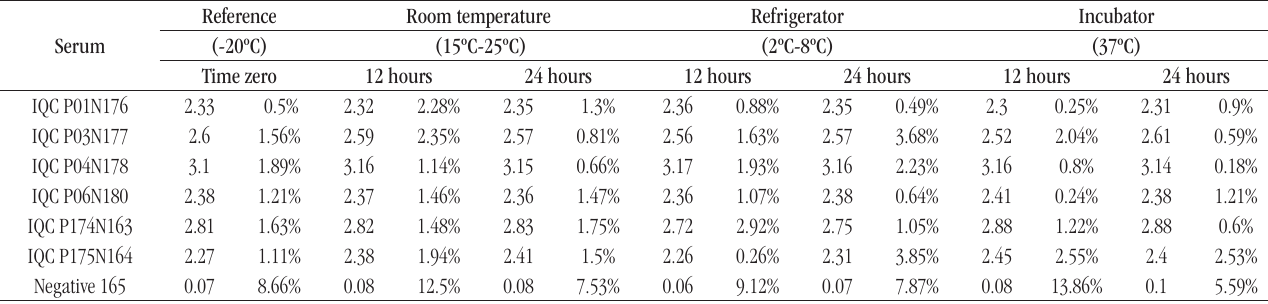
taBLE 1 − Results expressed as index means in chemiluminescence assay and coefficient of variation (%) of sample triplicates detected in the reference sera and test